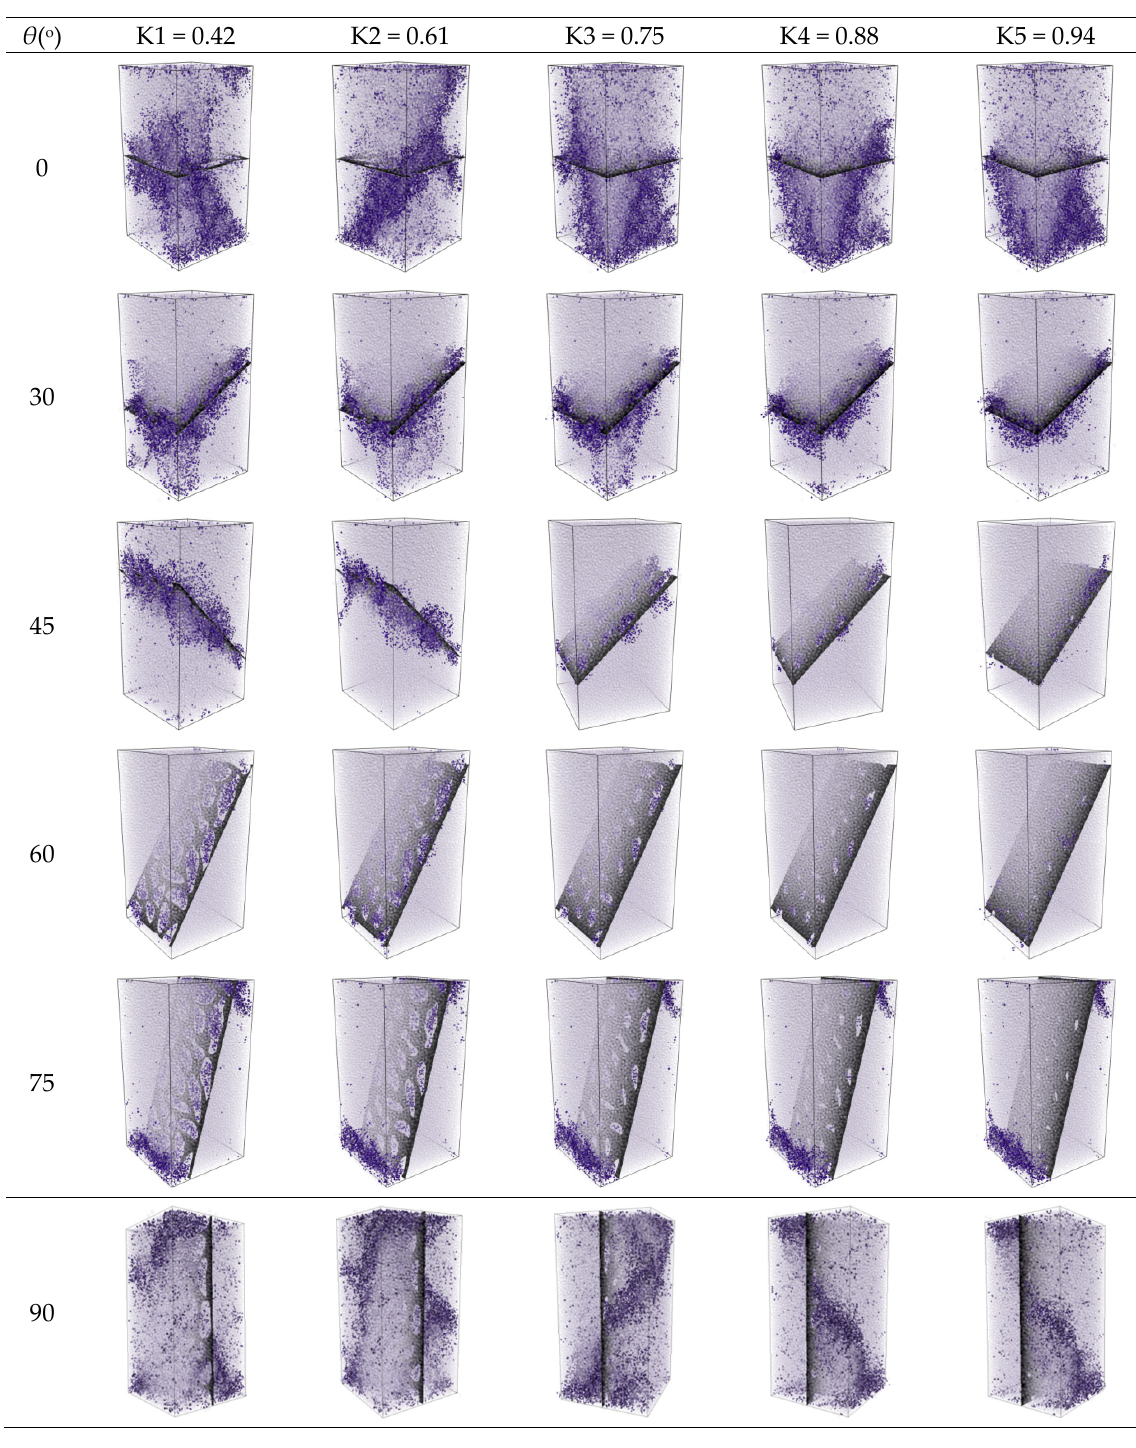
Figure 6. Failure patterns for jointed specimens with different joint parameters.